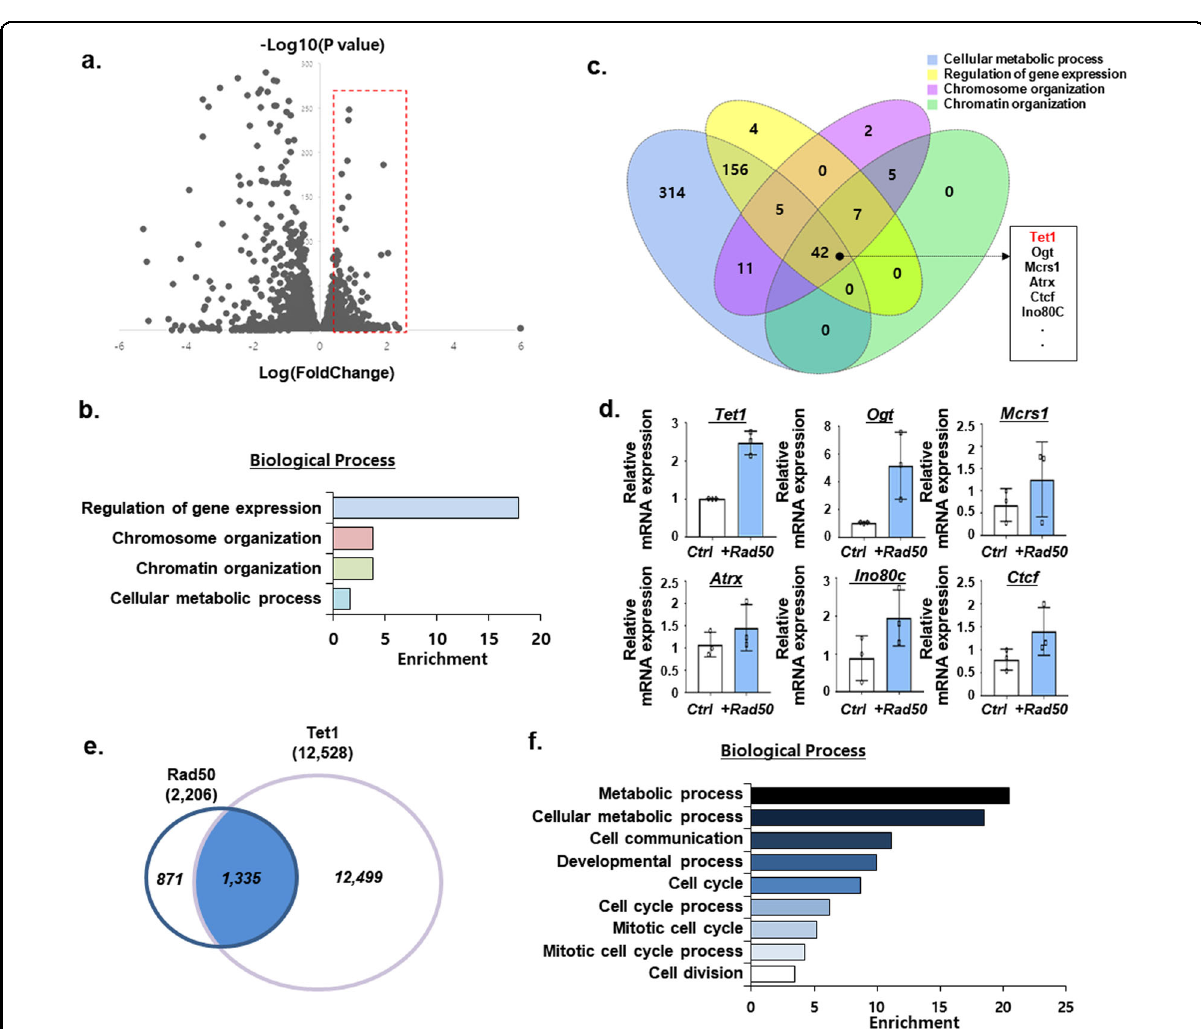
0.3). b GO enrichment analysis of signi fi cant upregulation as a result of Rad50 overexpression, as determined by RNA-seq analysis. c Venn diagram of the distribution of GO categories, cellular metabolic process, regulation of gene expression, chromosome organization, and chromatin organization, in Fig. 4b. d Quantitative real-time PCR validation of selected genes detected by RNA-seq analysis. Data are expressed as the mean ± SEM, n = 3. * p < 0.05 and ** p < 0.01, two-sided Student ’ s t test. e Venn diagram showing overlapping binding regions shared between Rad50 and Tet1, as determined by Chip-seq analysis. f GO enrichment analysis of overlapping binding regions shared between Rad50 and